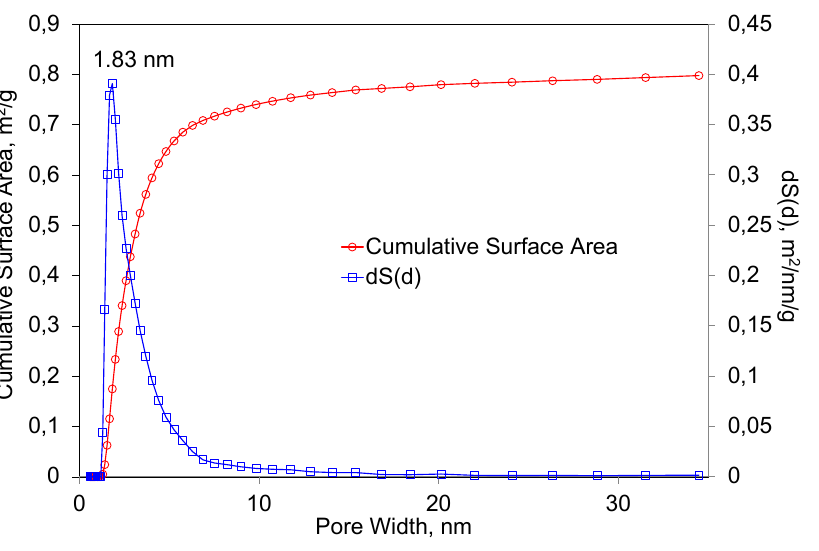
Figure 6. The dependence of the total surface area of the primary powders on the pore diameter.